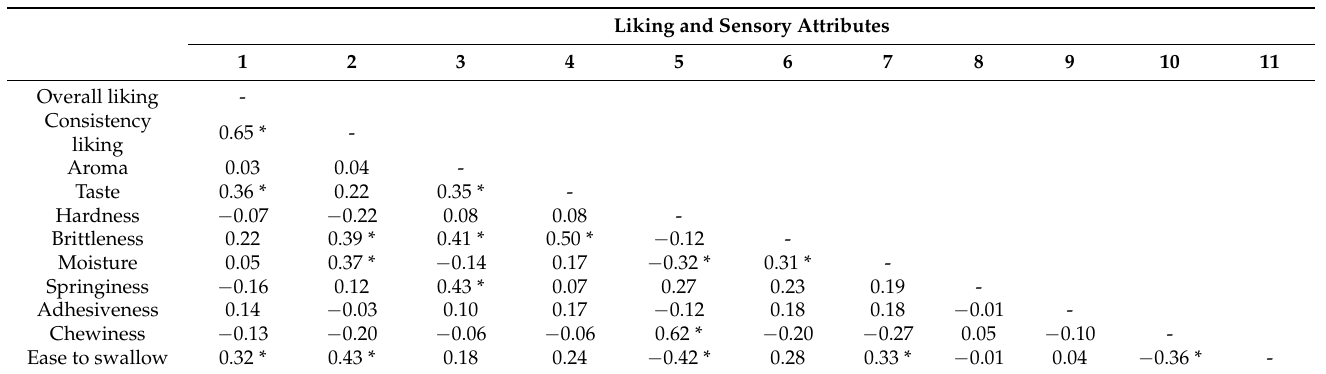
Table 7. Pearson’s correlations among liking and sensory attributes of PGs. Liking and Sensory Attributes